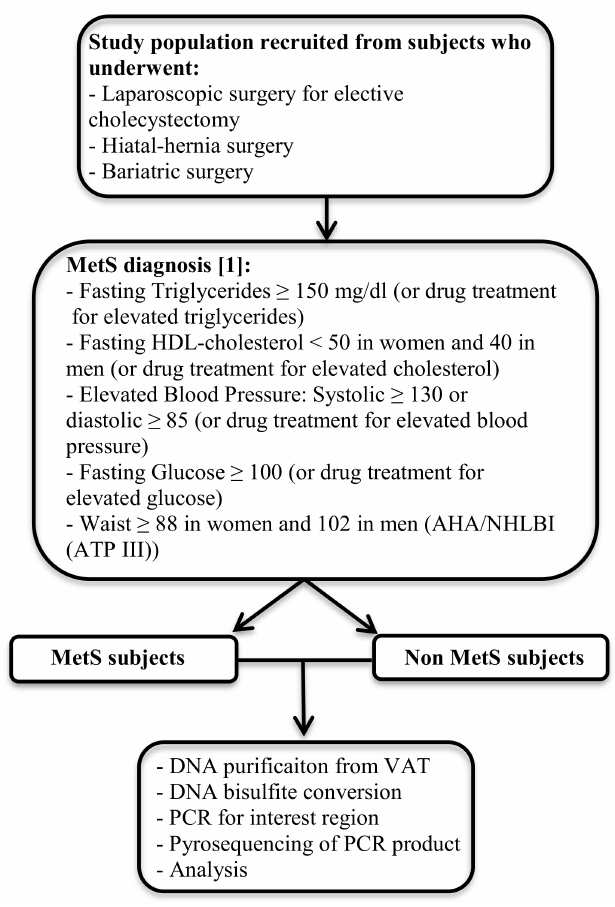
Figure 1. Diagram presenting the workflow of the study to measure global and specific DNA methylation